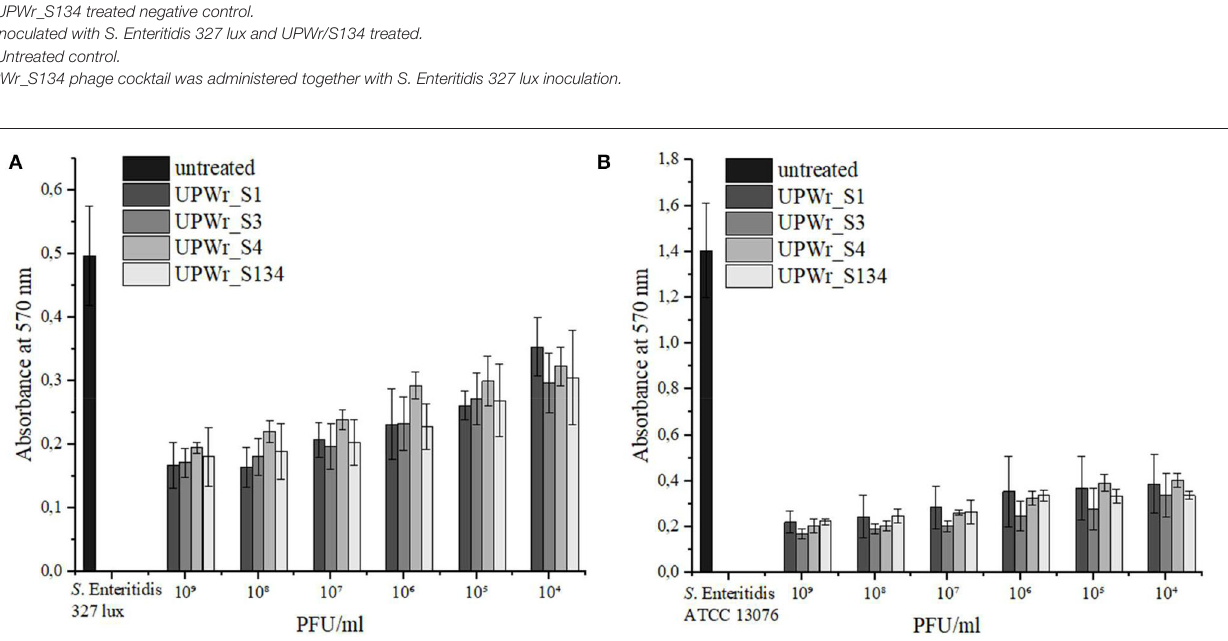
FIGURE 1 | Effect of UPWr_S1, UPWr_S3, and UPWr_S4 phages and phage cocktail UPWr_S134 on biofilm in 96-well microplate. (A) Effect of UPWr_S1, UPWr_S3, and UPWr_S4 phages and phage cocktail UPWr_S134 on reduction of biofilm formed by S . Enteritidis 327 lux, and (B) Effect of UPWr_S1, UPWr_S3, and UPWr_S4 phages and phage cocktail UPWr_S134 on reduction of biofilm formed by S . Enteritidis ATCC 13076. Values represent the mean with a standard deviation of three